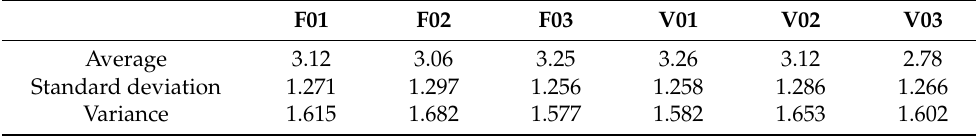
Table 3. Students participating in the activity and the evaluation questionnaire. Activity Questionnaire Percentage of Center QuestionnaireFrequency